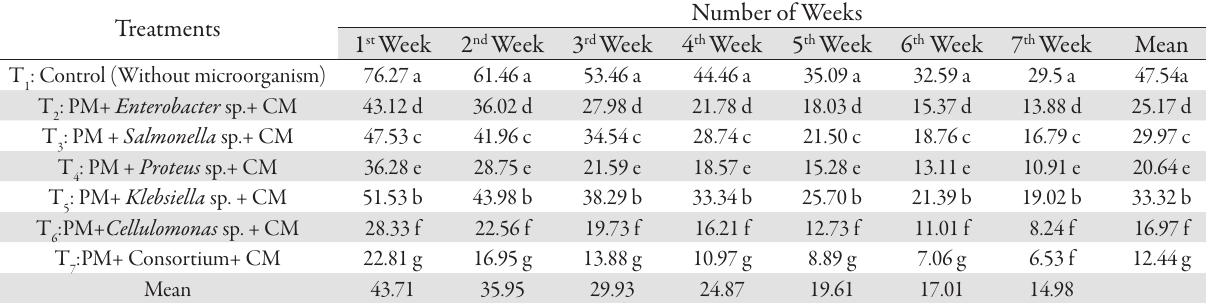
Tab. 3. Changes of C:N ratio during composting of press mud